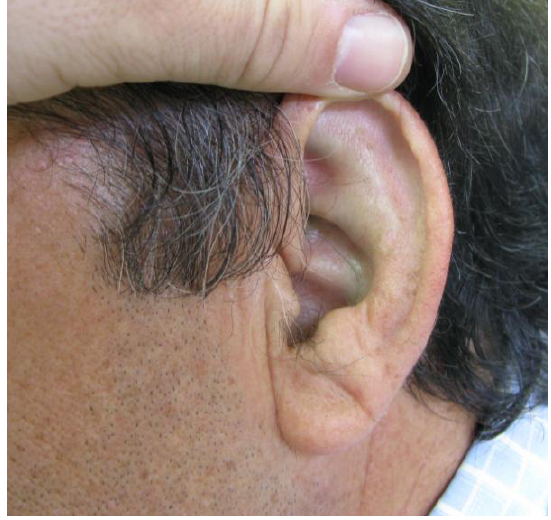
FIGURE 1 . The (L) ear with blue-gray